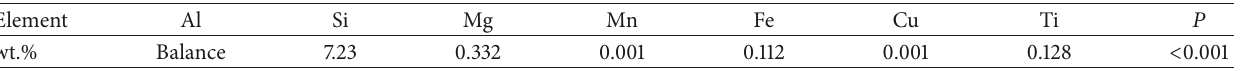
Table 2: Chemical composition of the A356